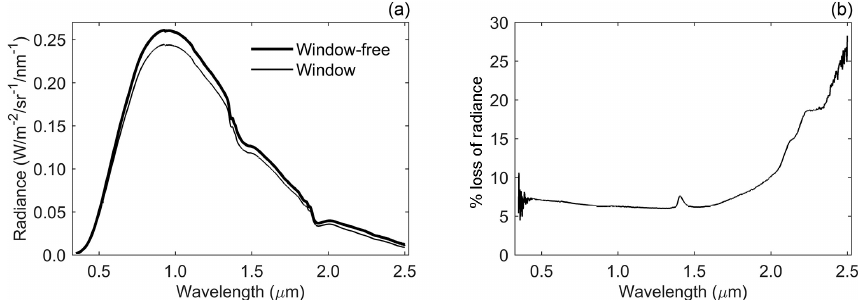
Figure 3. A measure of light transmission through the BK7 optical window mounted within the OrangeCan. Panel (a) shows the NIST- traceable-source output with and without the optical window. Panel (b) summarizes wavelength-dependent radiance loss due to window